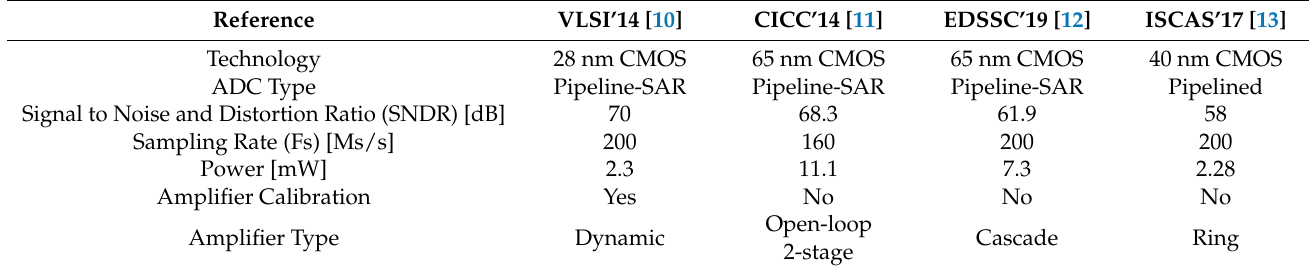
Table 1. The performance comparison of ADCs with pipelined structure.